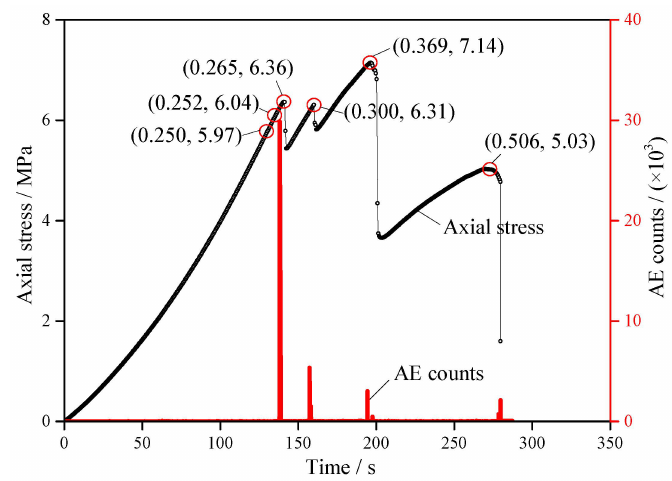
Figure 8. Acoustic emission (AE) response characteristics of the specimen under uniaxial compression ( α = 30 ◦